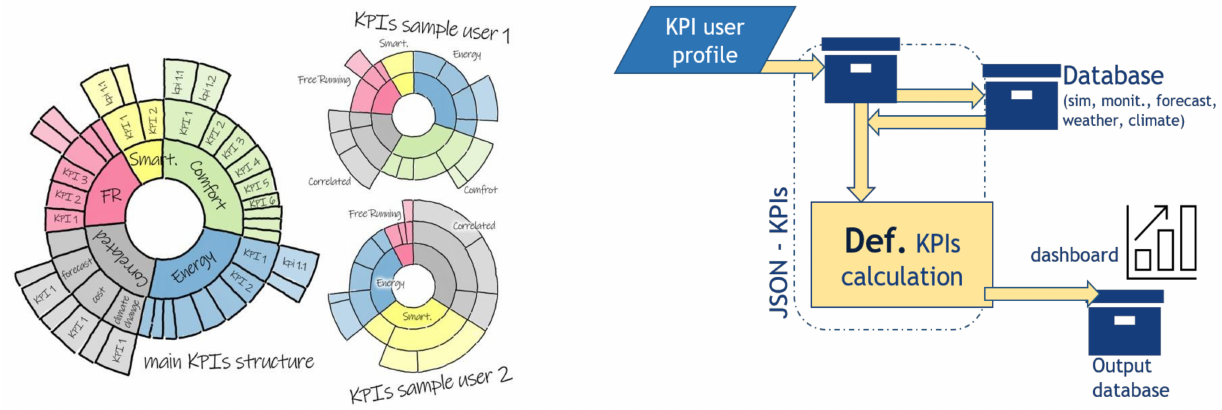
Figure 2. ( a ) The adopted modular approach to KPIs [20] and ( b ) the PREDYCE organization of the output and the KPI calculator